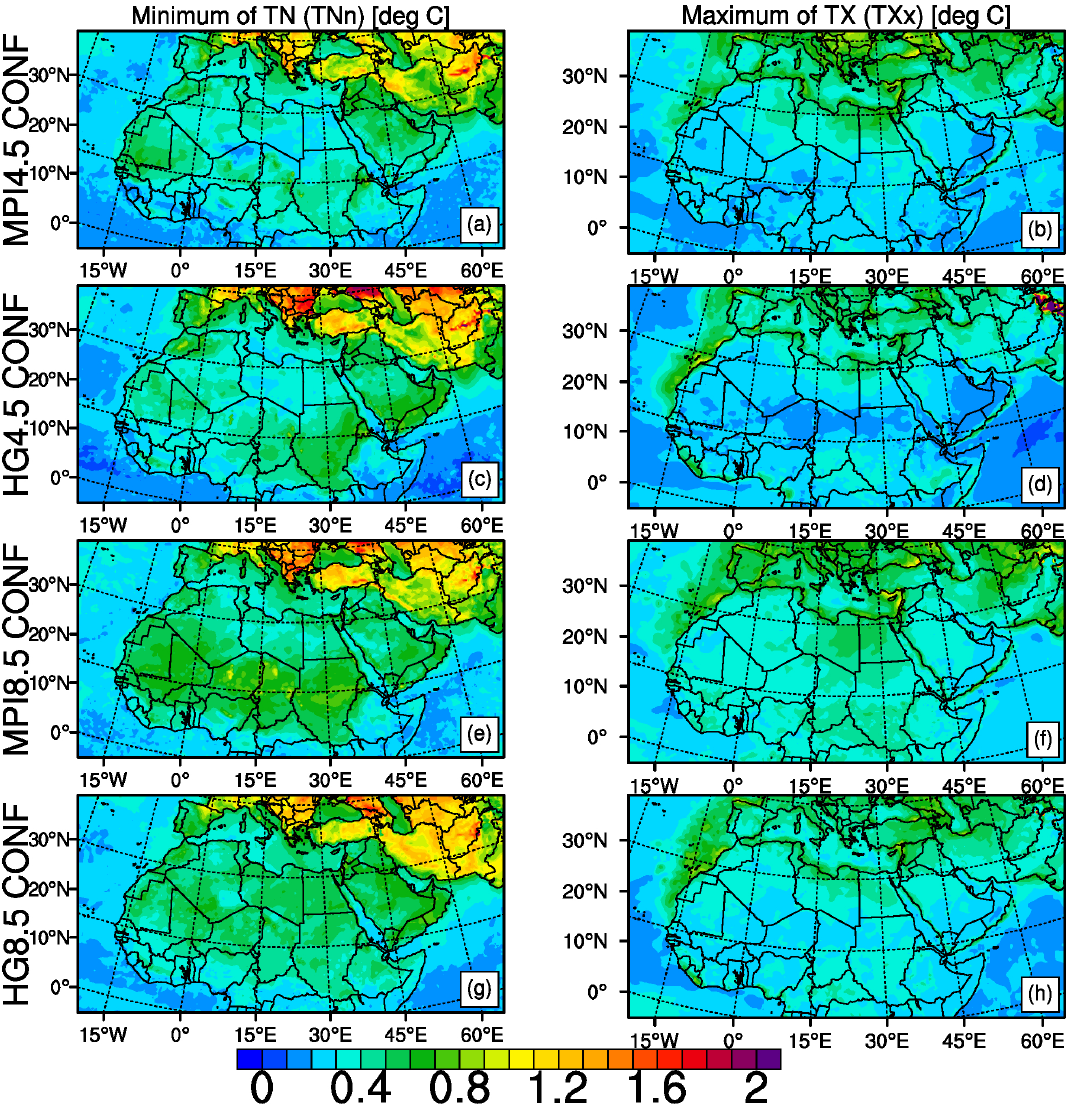
Figure 2. The 95 percentile confidence ranges of temporally averaged changes in TNn ( a , c , e , g ) and TXx ( b , d , f , h ) for the period of 2071–2100 displayed as differences (in ◦ C) with respect to the reference period 1971–2000 for the model MPI-ESM-MR with RCP4.5 ( a , b ) and with RCP8.5 ( e , f ) and for the model HadGEM2-ES with RCP4.5 ( c , d ) and with RCP8.5 ( g , h